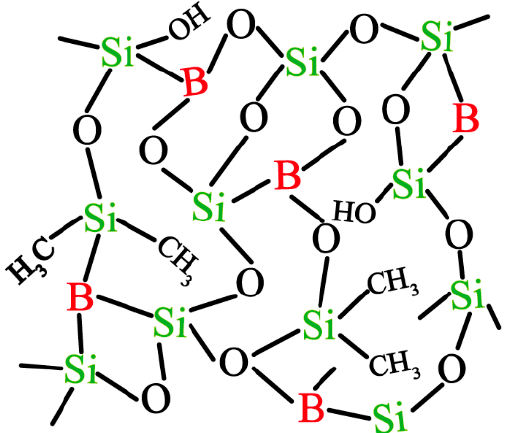
Figure 1. The three-dimensional network structure of Figure 1. The three ‐ dimensional network structure of SiBCO.